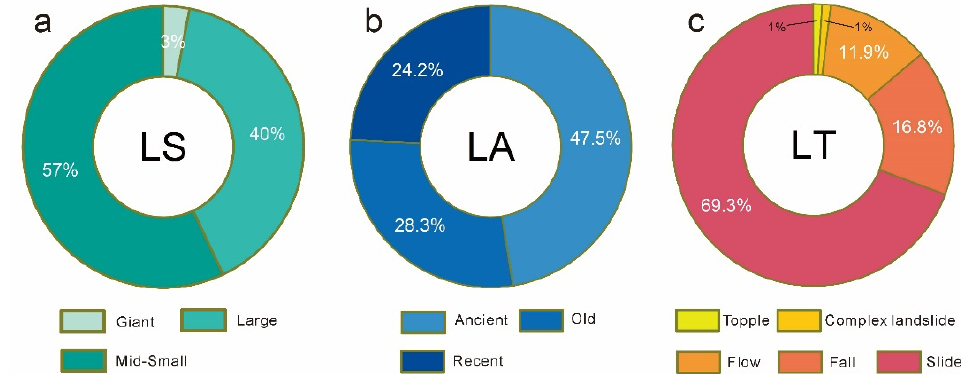
Figure 6. Proportional distribution of the three landslide types. ( a ) LS landslide size, ( b ) LA landslide age, ( c ) LT landslide type.